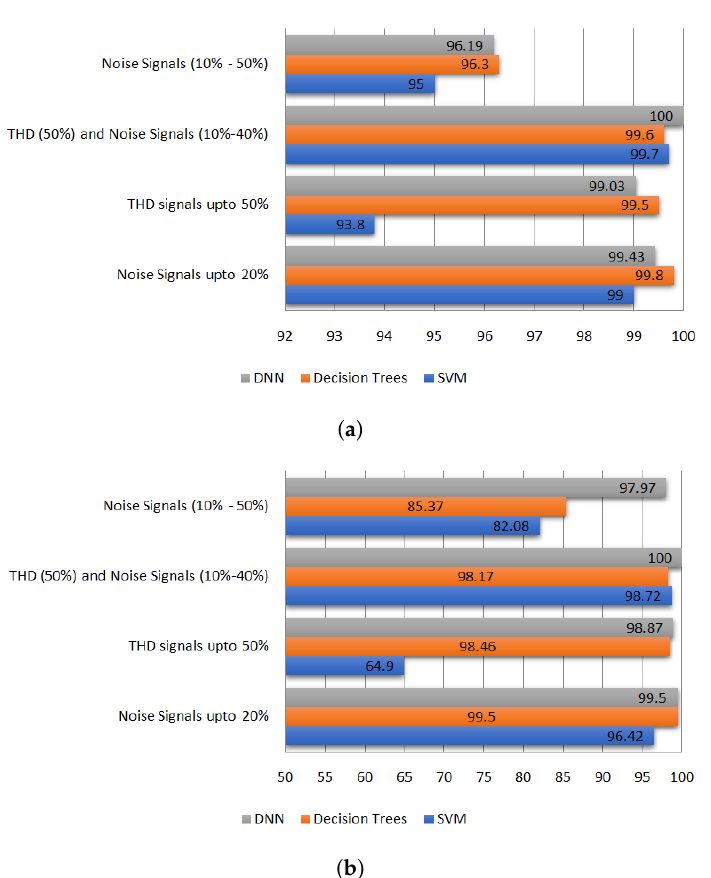
Figure 15. Validation of proposed DNN model. ( a ) Validation of proposed model in terms of training accuracy. ( b ) Validation of proposed model in terms of testing